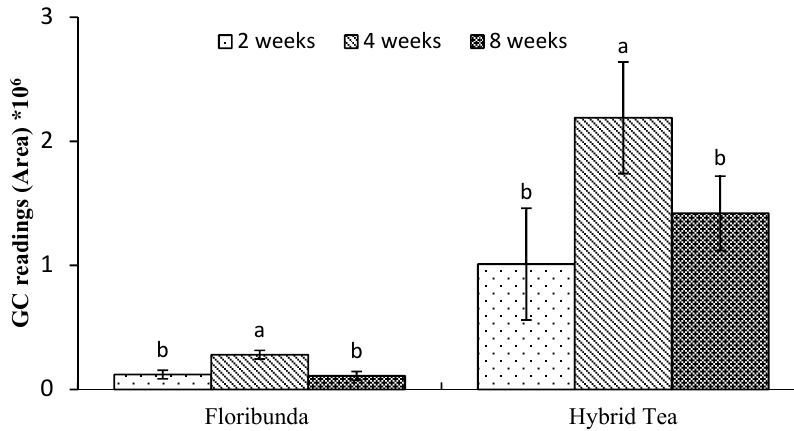
Figure 1. Comparison of the main peak areas at different sampling times for the analysis of volatile compounds collected from flowers of two rose varieties. Bars represent least significant differences (LSD) of the means at ( p < 0.05) ( n = 3).